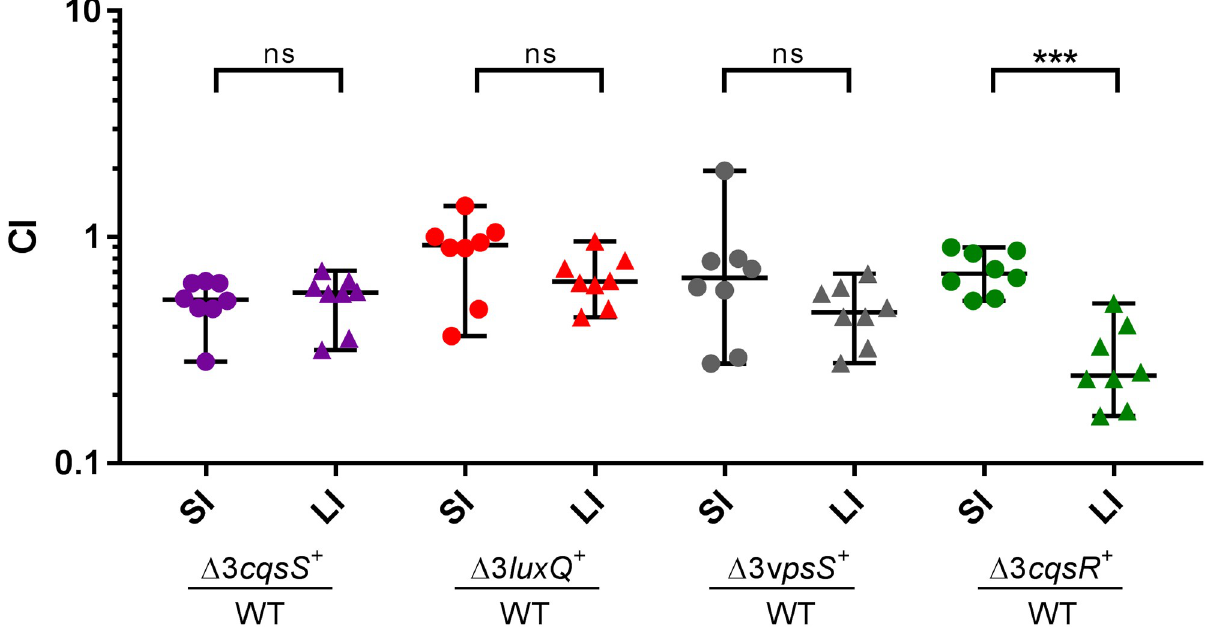
Fig 2. Effect of QS receptor mutations in V . cholerae infection of the small and large intestine. Competitive indices (CI) were determined between wild-type Δ lacZ and the indicated V . cholerae mutants in the small intestine (SI) and large intestine (LI) of infant mice 24 hr post-infection (n = 8). Δ 3 represents triple receptor mutants with the remaining receptor shown in italics. Each symbol represents the CI in an individual mouse and data is represented with horizontal lines indicating the median with a 95% confidence interval for each competition. ��� P < 0.001; ns = no significance (unpaired t